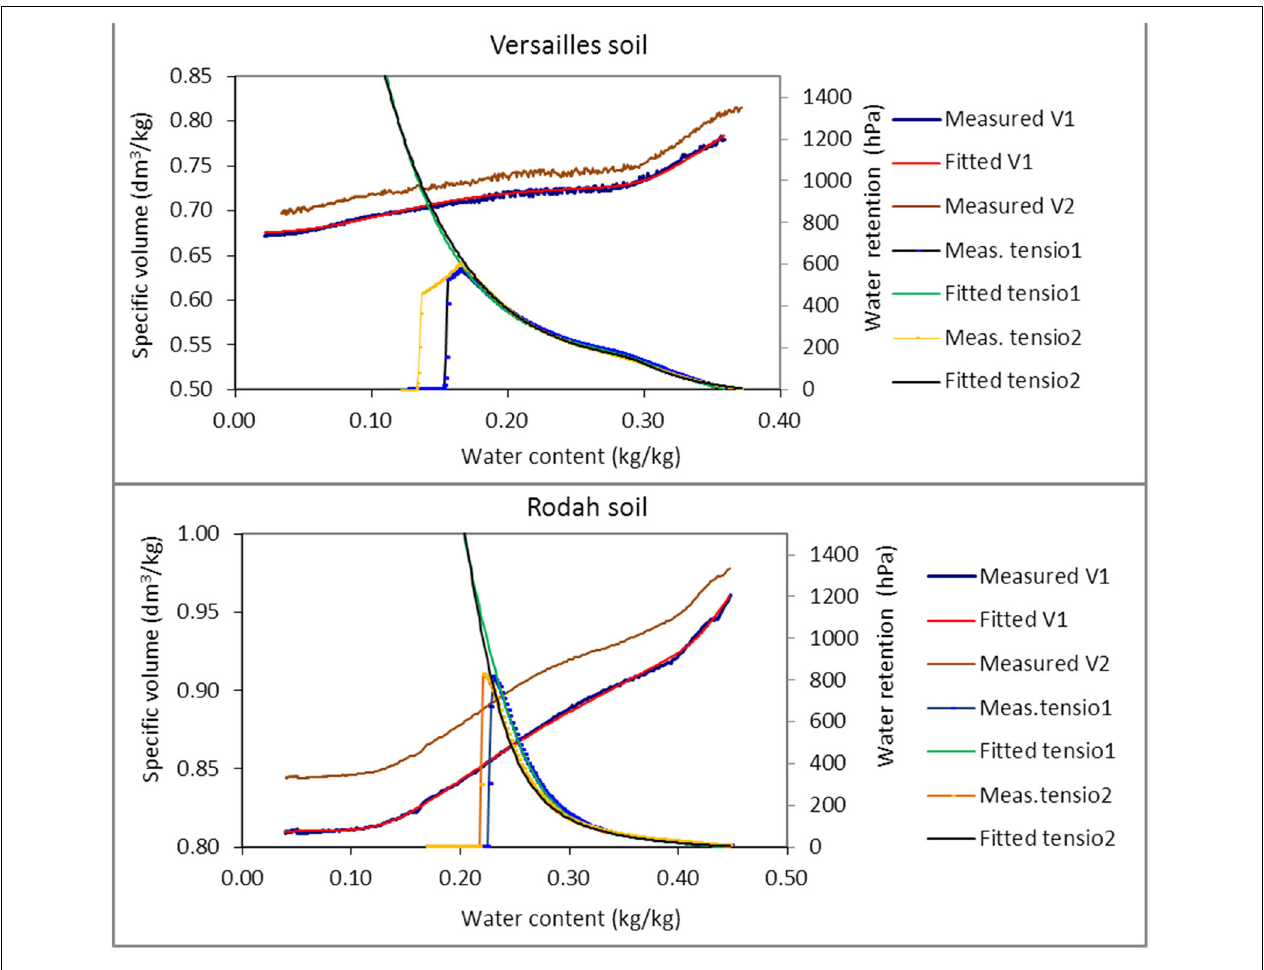
FIGURE 1 | Pedostructural moisture characteristic curves of two replicates of a pedostructure sample of two soils. For each soil, the curves of the two replicates are represented: (i) The measured (blue points) and fitted (red) shrinkage curve (ShC), for replicate 1; (ii) The